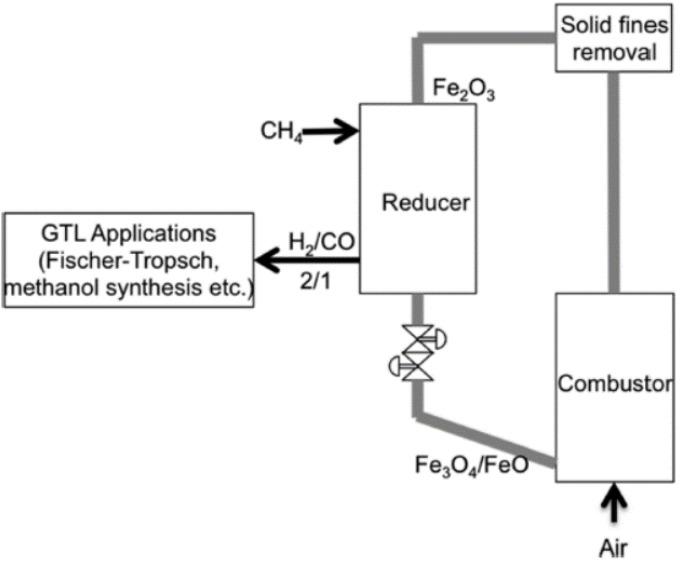
Figure 1. Illustration of the CH 4 partial oxidation-based Fe-oxide system for producing syngas. Reprinted from [13]. Copyright (2015), with permission from the American Chemical Society.